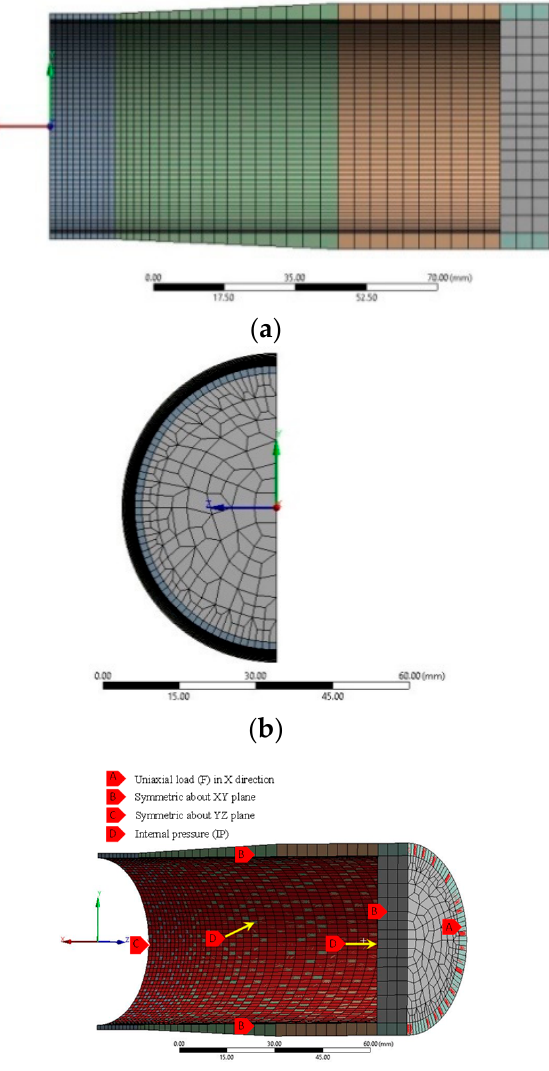
Figure 18. Finite element model of biaxial specimen: ( a ) Inside surface symmetric about X-Y plane, ( b ) through thickness symmetric about Y-Z plane, ( c ) boundary condition.